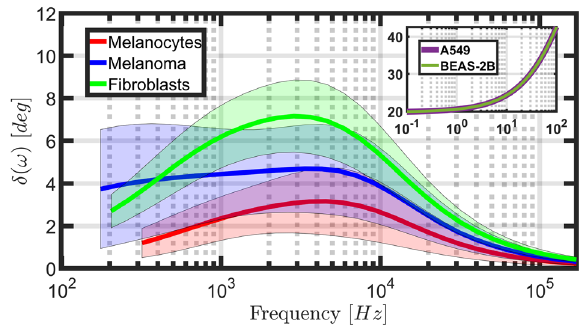
Fig. 6 Loss angle comparison of the generalized Maxwell viscoelastic model and power law rheology (PLR) models for various adherent human skin cell types. The generalized viscoelastic models showcase non- monotonic behavior for all human skin cell lines across a wide frequency range when compared with the relatively smooth and monotonic PLR model prediction for human lung epithelial cells. Loss angles have been provided for each cell type and showcase nonlinear, non-monotonic action as a function of frequency. This is in contrast to the inset data, which was reproduced from the literature 5 using a PLR model for human lung epithelial cells and shows a completely monotonic response with increasing frequency. While the frequency ranges for the primary axis and inset do not overlap, the PLR model is clearly lacking in frequency domain features and is merely provided to represent a typical PLR model prediction. Observed con fi dence intervals are shaded in matching colors for each model. When comparing all three skin cell types, the melanocyte and fi broblast models showed noticeably tighter con fi dence intervals than the melanoma. As with Fig. 4, these loss angle estimates were obtained by analyzing an average of 70, 71, and 193 force curves from the melanoma, melanocyte, and fi broblast cell conditions, respectively. In total, the averaged datasets contain curves collected from 13 unique melanoma cells, 12 unique melanocytes, and 33 unique fi